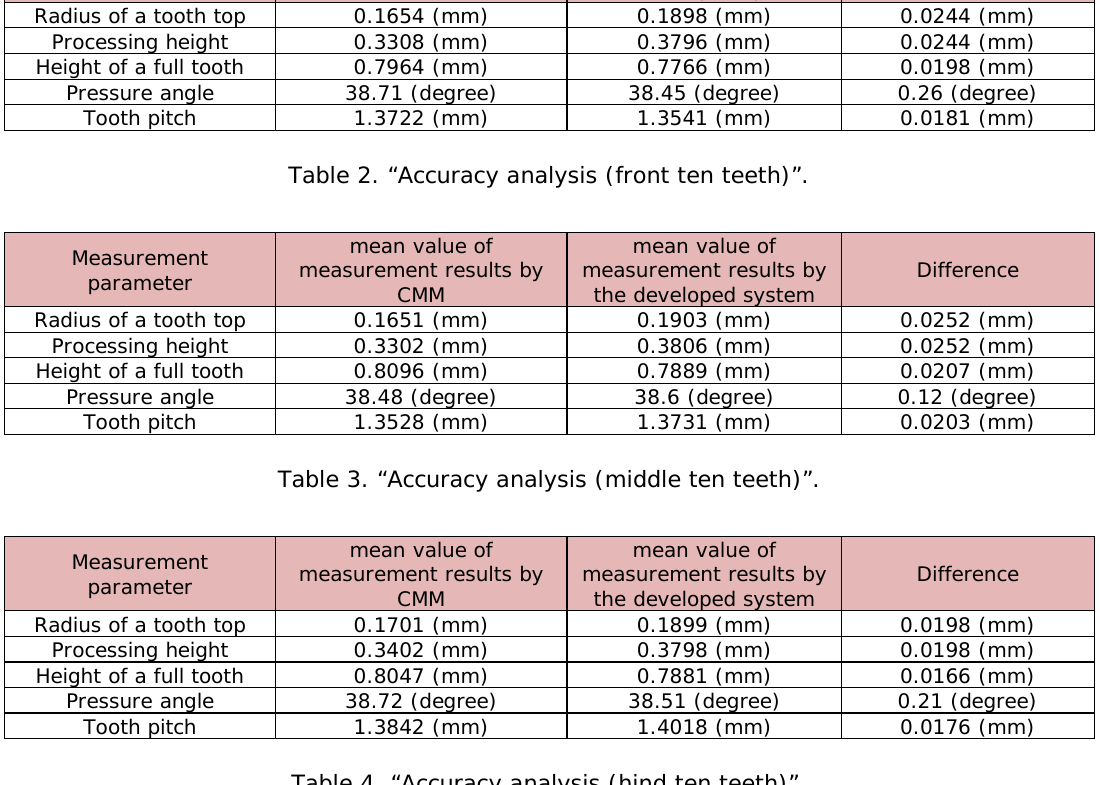
Table 4. “Accuracy analysis (hind ten teeth)”.